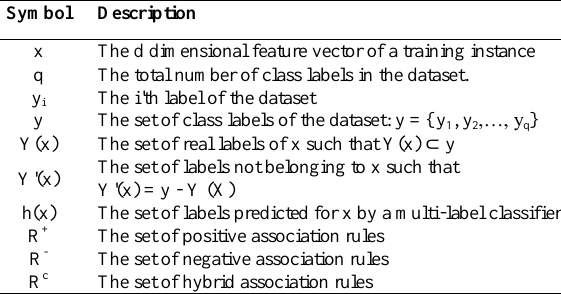
Table 1. Notations used in this